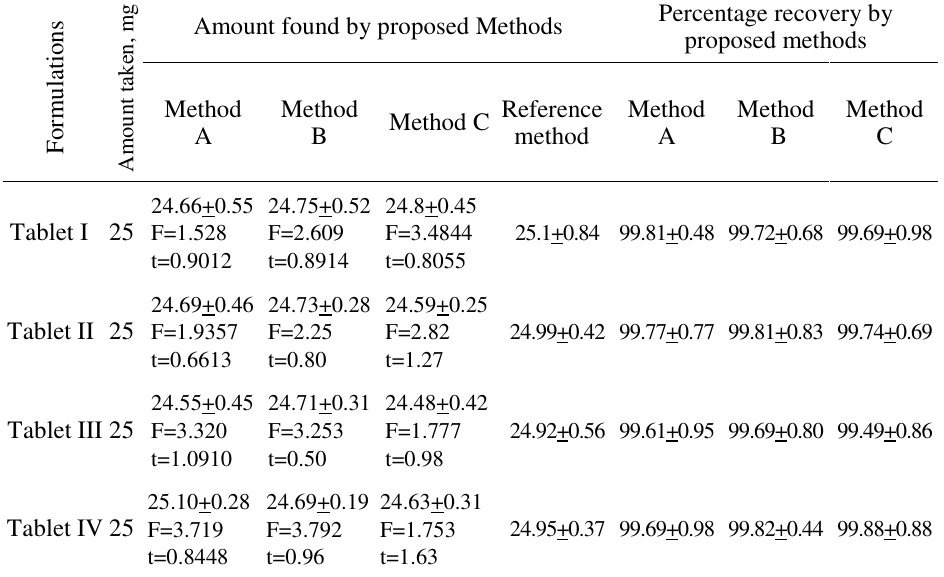
Percentage recovery